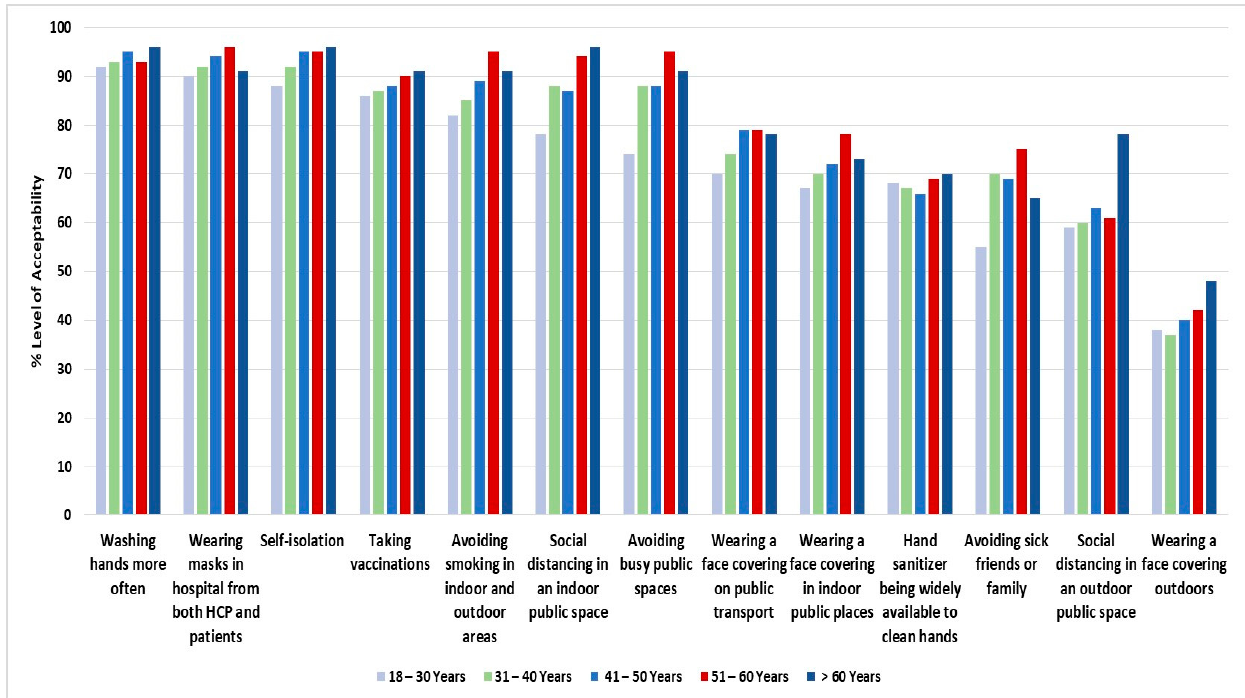
Figure 1. The acceptability of policies regarding respiratory virus infection control interventions by age. Table 2. Acceptability of respiratory virus infection control interventions. Data are percentages of